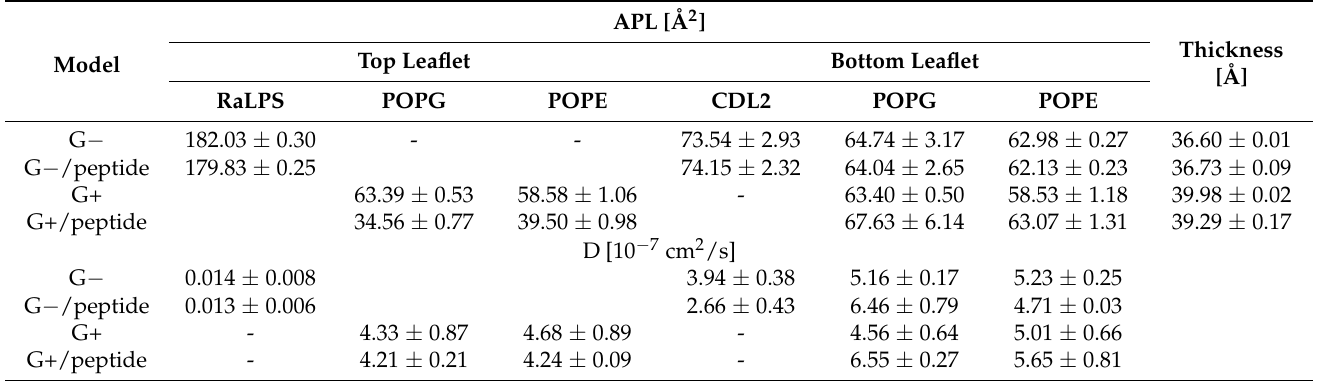
Table 5. The average and standard deviation of the APL, bilayer thickness and lateral diffusion coefficients calculated over the last 100 ns of the CG MD